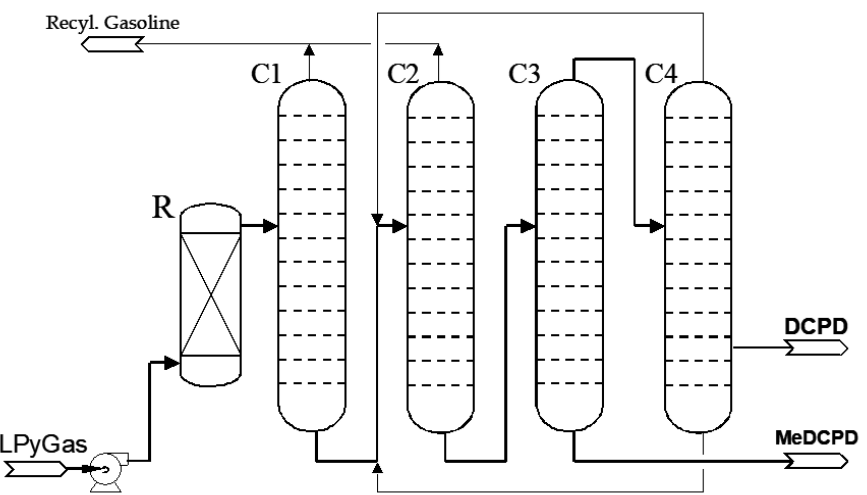
Figure 1. Process scheme for dicyclopentadiene (DCPD) recovery from light pyrolysis gasoline (LPyGas).